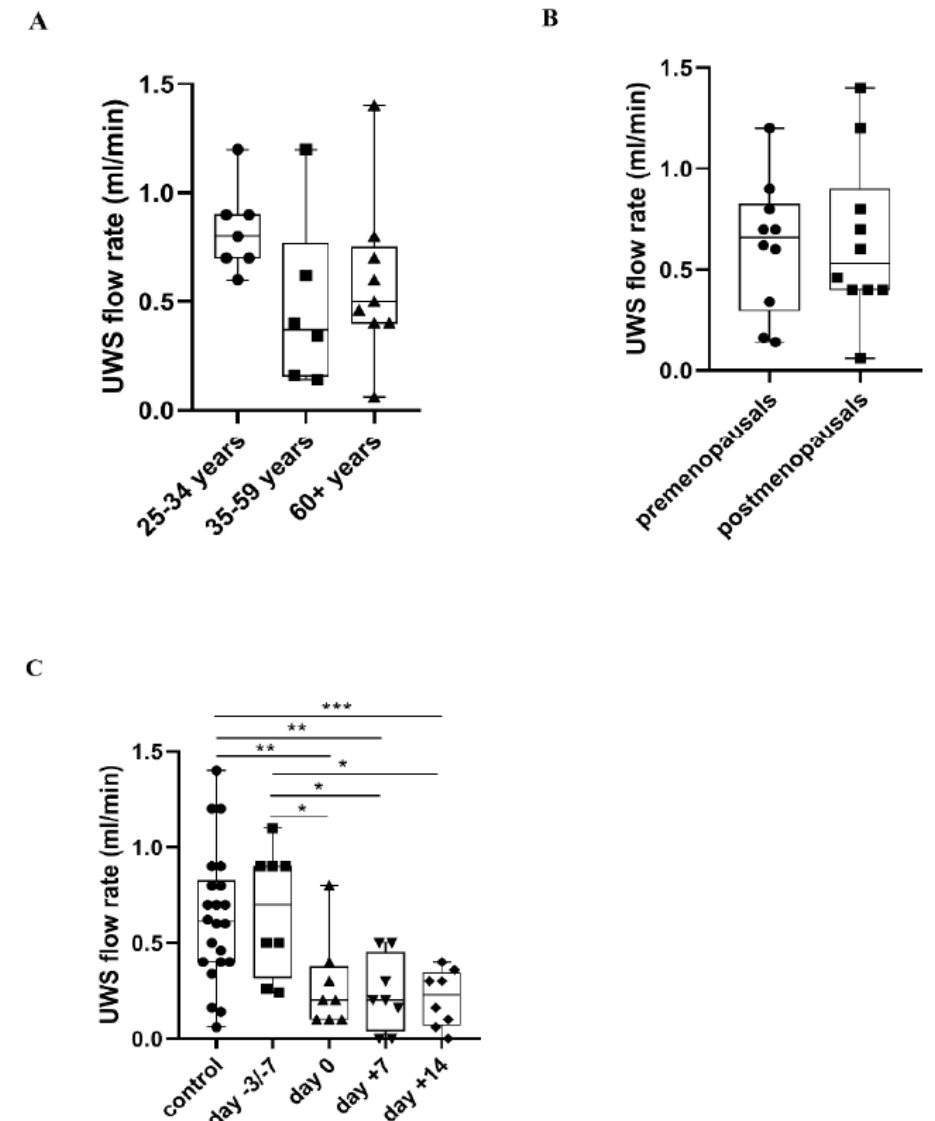
Figure 4. Changes in unstimulated whole saliva (UWS) flow rate in healthy controls in relation to age ( A ) and hormonal status of women ( B ), and during autologous peripheral stem cell transplanta- tion (APSCT) ( C ) compared to controls. The start of conditioning therapy (day − 3 in patients with multiple myeloma receiving melphalan and day − 7 in patients with lymphoma receiving BEAM conditioning) was defined as the first day of samplings. Values are expressed as sample means. The small black configurations (dots, triangles, squares, etc.) are individual data points, and the box plots denotes the data mean. Error bars represent the standard deviations which describe average difference between the data points and their mean. (* p < 0.05, ** p < 0.01, *** p <